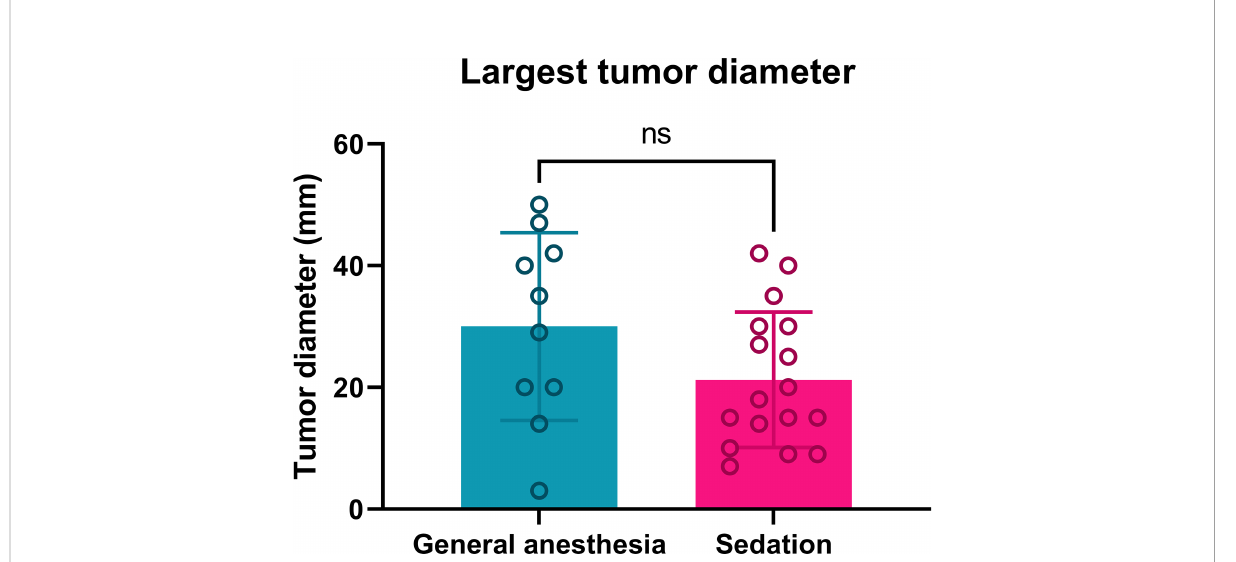
FIGURE 1 Tumor diameters of patients treated by ECT under general anesthesia or continuous intravenous sedation. Ns: nonsigni fi cant; p = 0.0993.